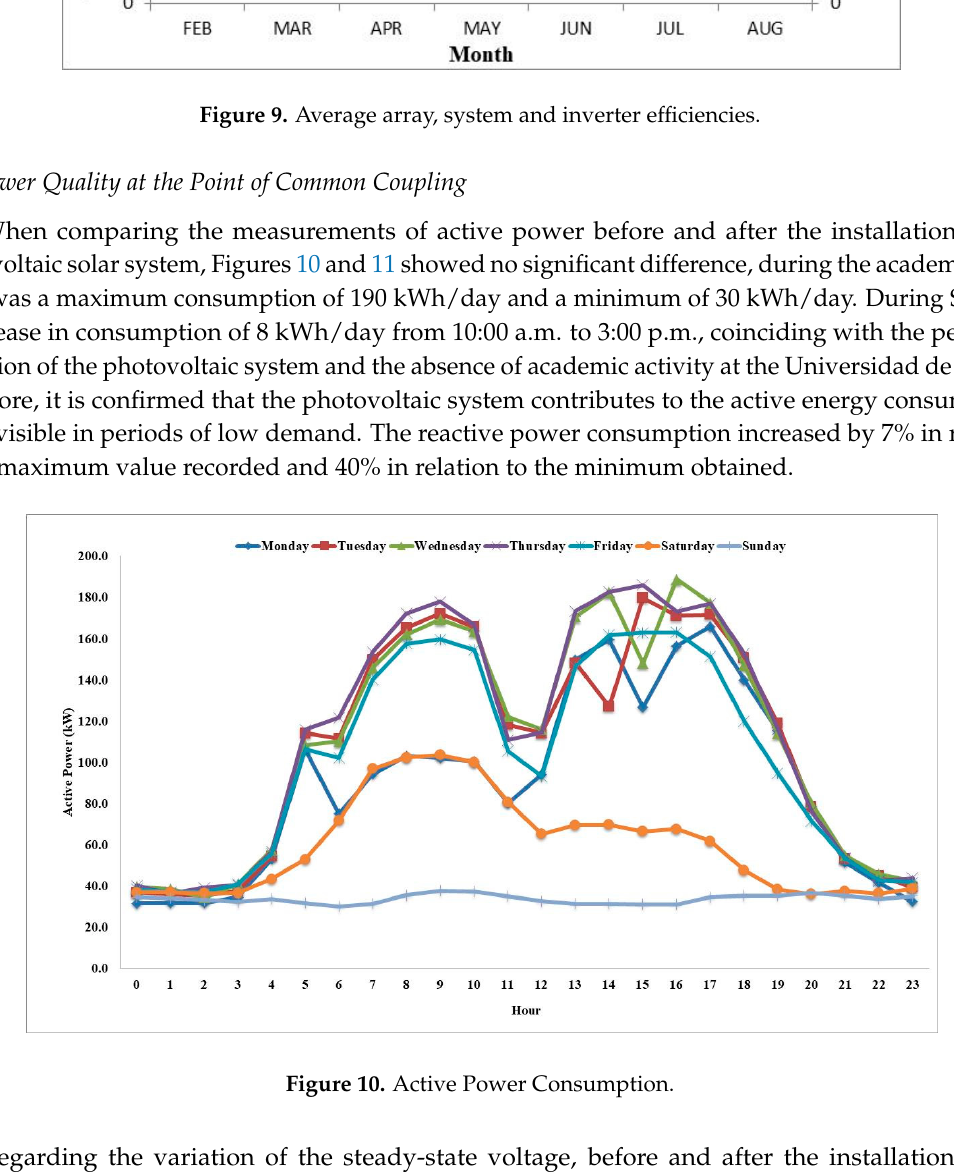
Figure 11. Reactive Power Consumption. Regarding the variation of the steady-state voltage, before and after the installation of the photovoltaic system, there is no negative impact on the lines (U 1 , U 2 and U 3 ), according to the guidelines of standards NTC 5001, IEC 038 and EM 50160, there were no overvoltages or undervoltages. Figures 12 and 13 represent the percentage of the recorded voltage values compared to the declared RMS voltage values (120 V). Figure 12. Comparison of the variation of the tension in steady state before the installation of the experimental system.